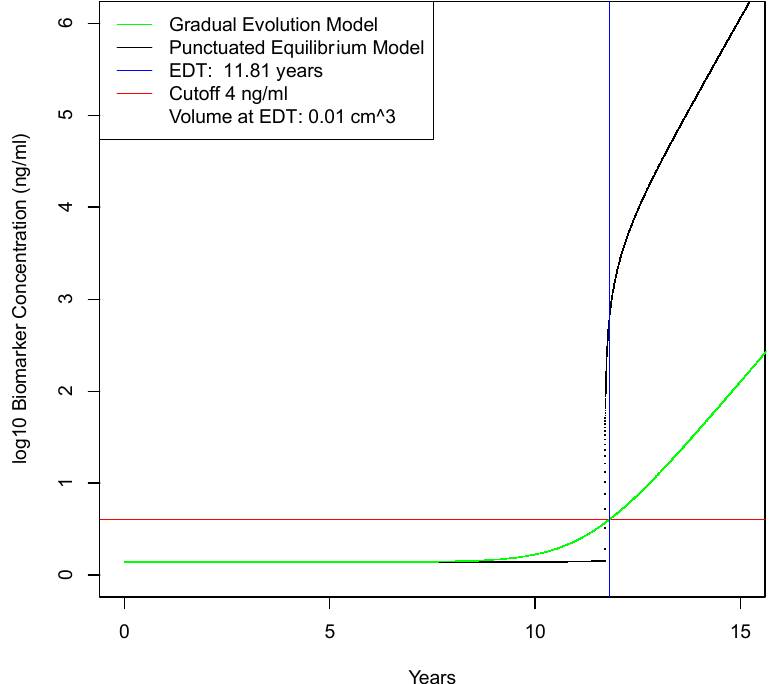
Figure 3. Earliest detection times in gradual evolution vs punctuated equilibrium models. In the first decade of tumor growth, the biomarker concentration in blood is due to secretion by normal cells. After this, biomarker concentration is increasingly due to tumor production. At approximately 11.8 years, blood biomarker levels reach 4 ng/mL, which is the assumed cut-off point for early detection with a blood test. This is approximately 1.5 year earlier than the limit of detection for medical imaging of 5 mm 3 .